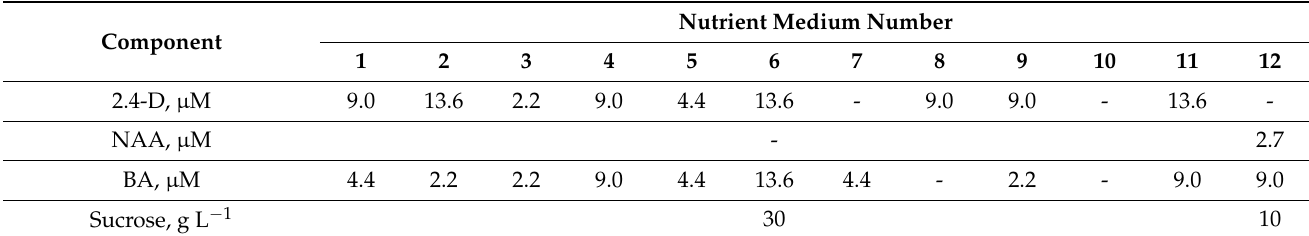
Table 1. The content of growth regulators and sucrose in different types of the DCR